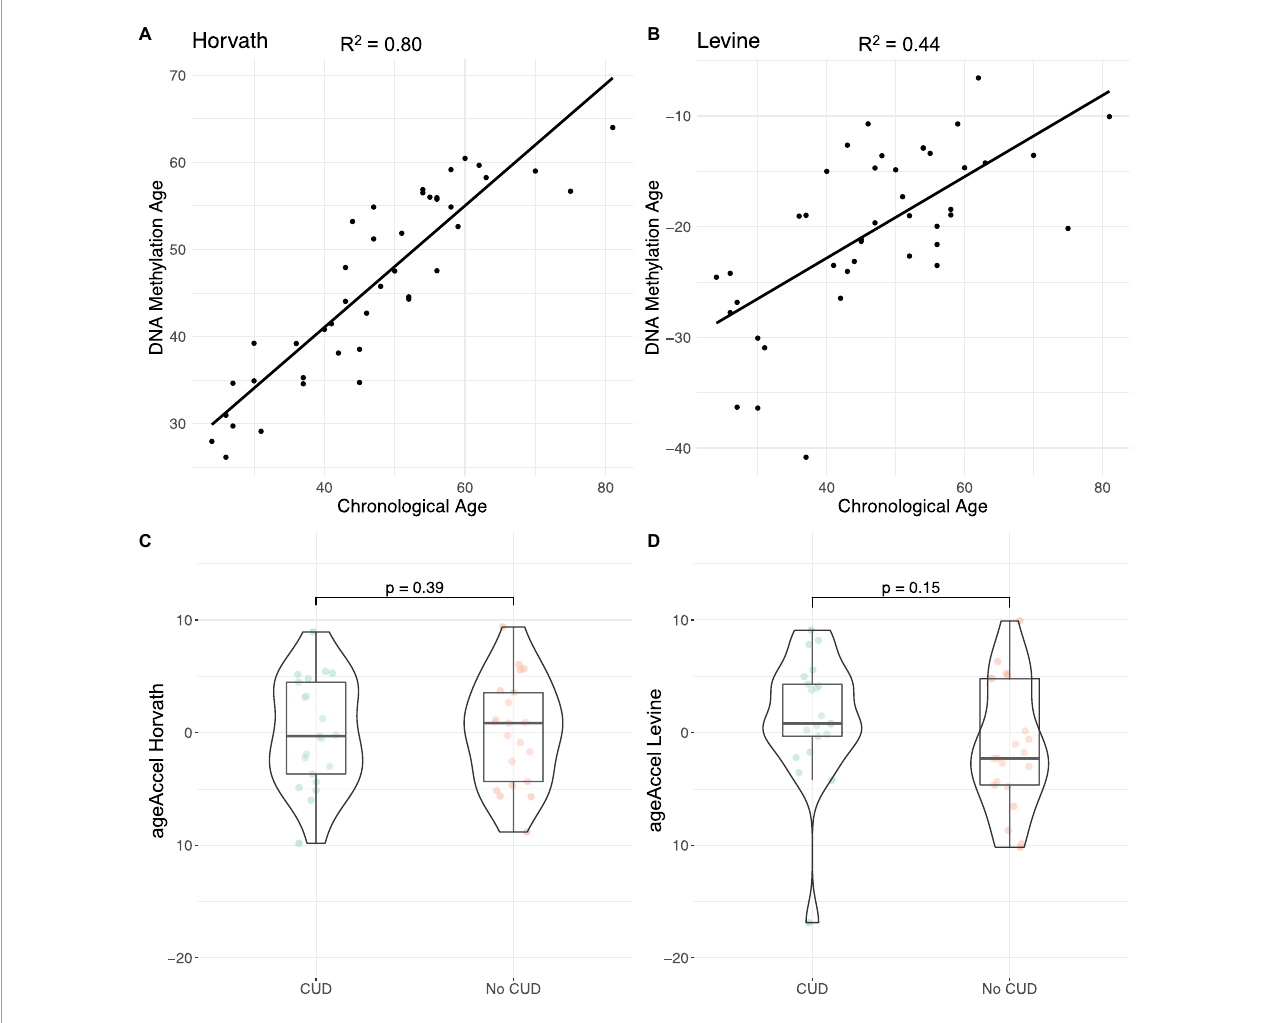
FIGURE4 Evaluation of epigenetic clocks in cocaine use disorder (CUD) using post-mortem human brain samples of Brodmann Area 9 (BA9). Correlation of chronological age with DNA methylation (DNAm) based (A) Horvath’s and (B) Levine’s epigenetic age estimates as implemented in the R package methylclock (46). Comparison of ageAccel between individuals with and without CUD using (C) Horvath’s and (D) Levine’s epigenetic clocks.